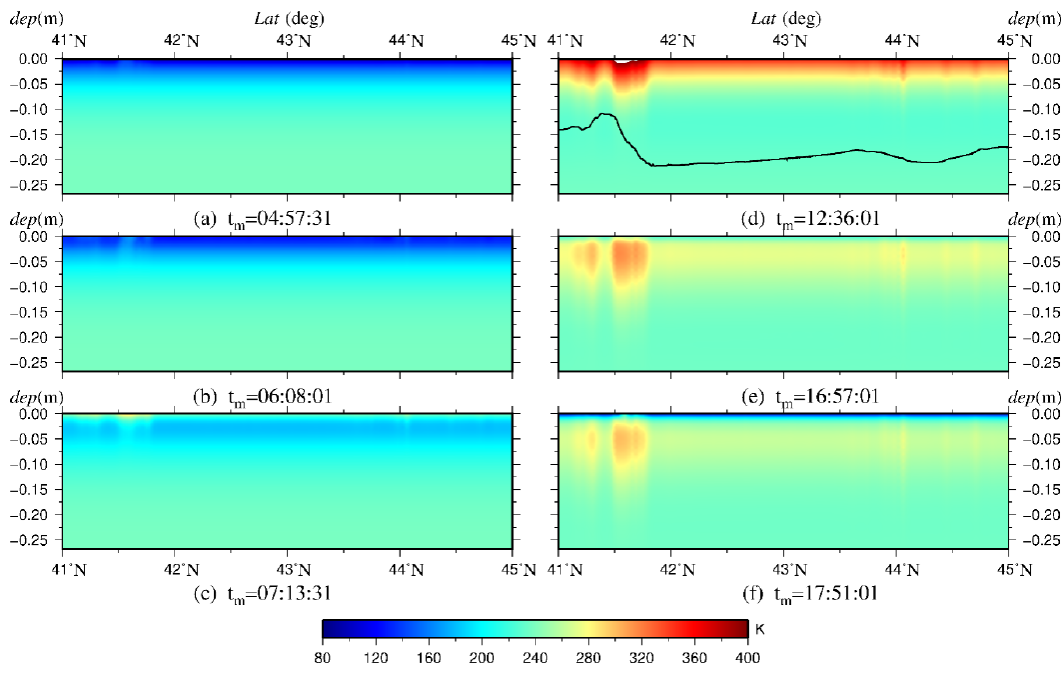
Figure 9. Temperature variation along the latitude direction. ( a ) UTC 2020-0-3T17:15:01; ( b ) UTC 2020-05-05T04:30:01; ( c ) UTC 2020-05-06T13:15:01; ( d ) UTC 2020-05-13T06:30:01; ( e ) UTC 2020-05-18T17:00:01; ( f ) UTC 2020-05-19T20:00:01. The black line in Figure 9d denotes the surface topography with fixed longitude 58.53 ° W but varied latitude. t m represents the lunar local time.